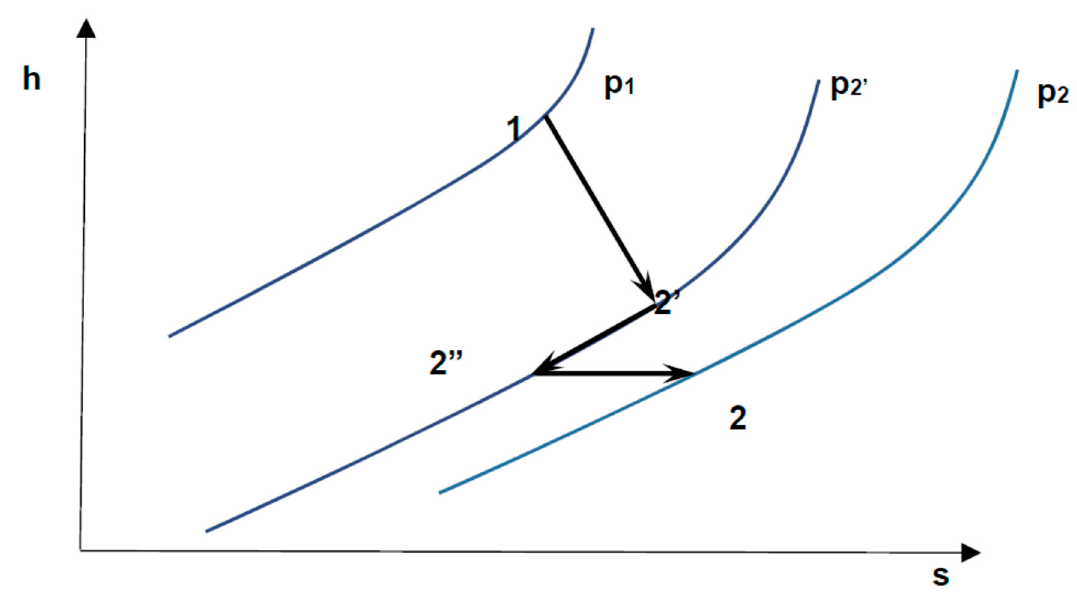
Figure 1. De Paepe’s cooled expansion with mixing losses (adapted from [10]).